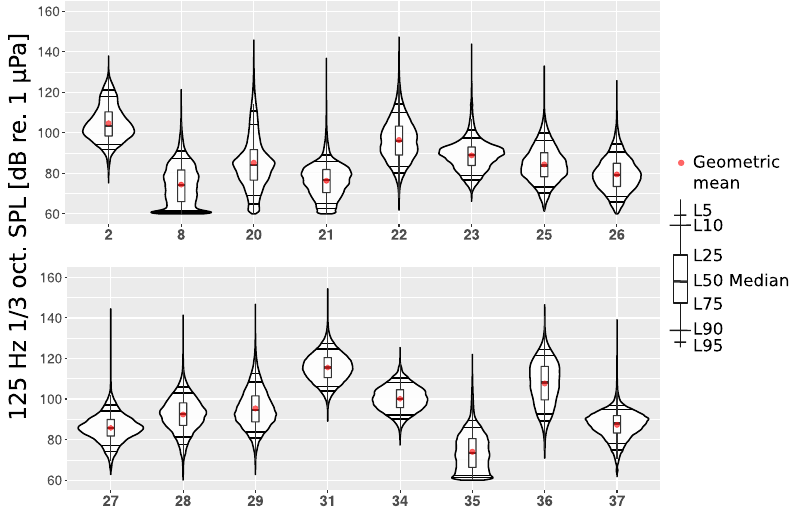
Figure 5. The annual estimated probability density functions of the SPL measured in sixteen different locations in the 125 Hz one-third octave band during the year